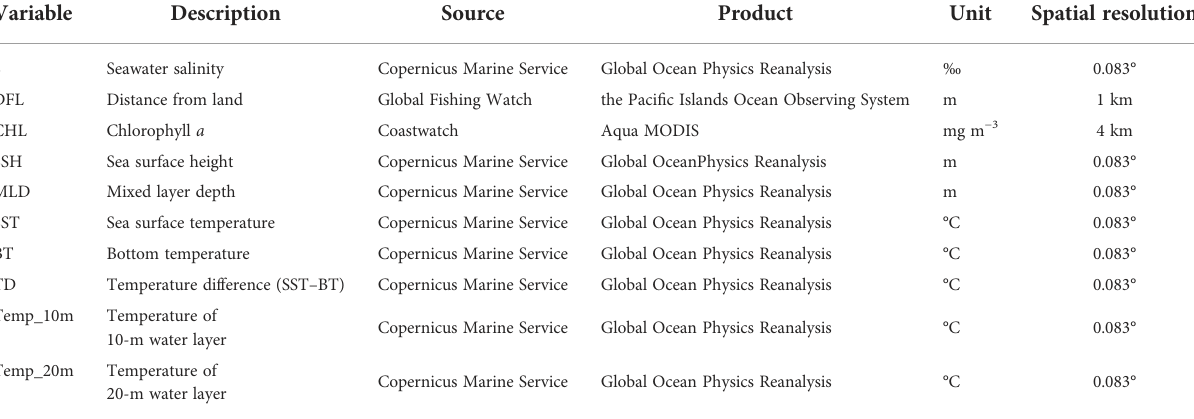
TABLE 1 Candidate factors for construction of the MaxEnt model for prediction of Trichiurus japonicus geographic distribution.